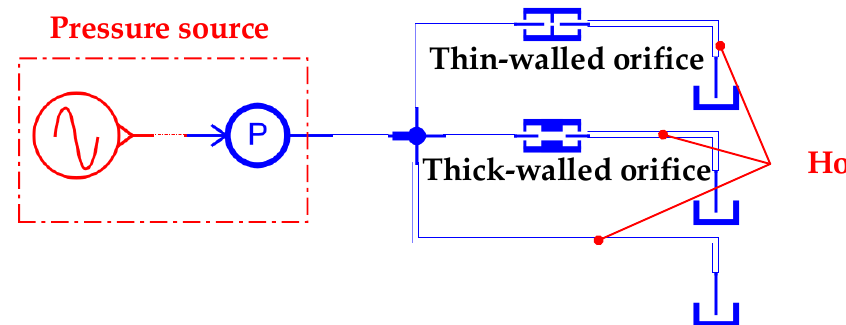
Figure 16. Simulation model of pressure oscillation with damped orifice. The parameters in the simulation model are as same as those in Table 2. The orifice parameters are shown in Table 4. Table 4. Orifice parameters. Diameter Length Diameter of Inlet Runner Model